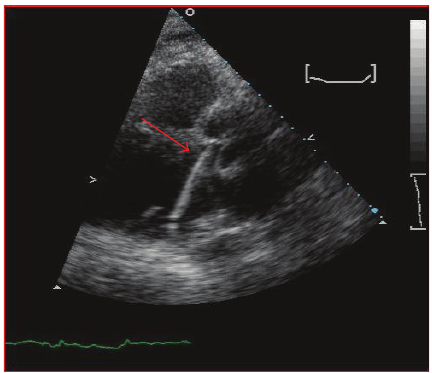
Figure 2: Parasternal long axis view showing the Impella catheter tip resting on the inferior basal wall (red arrow).